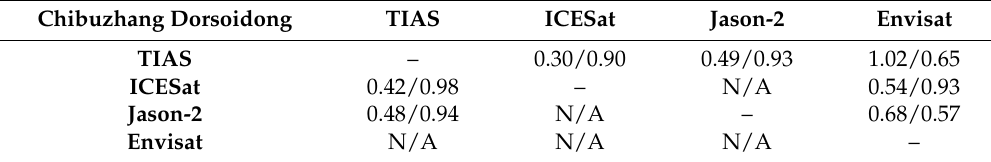
Comparison between sensors in the study area. Numbers in the matrix indicate root-mean-square of the difference (RMSD) in meters and Pearson’s correlation coefficient (CC). The format is RMSD/CC.